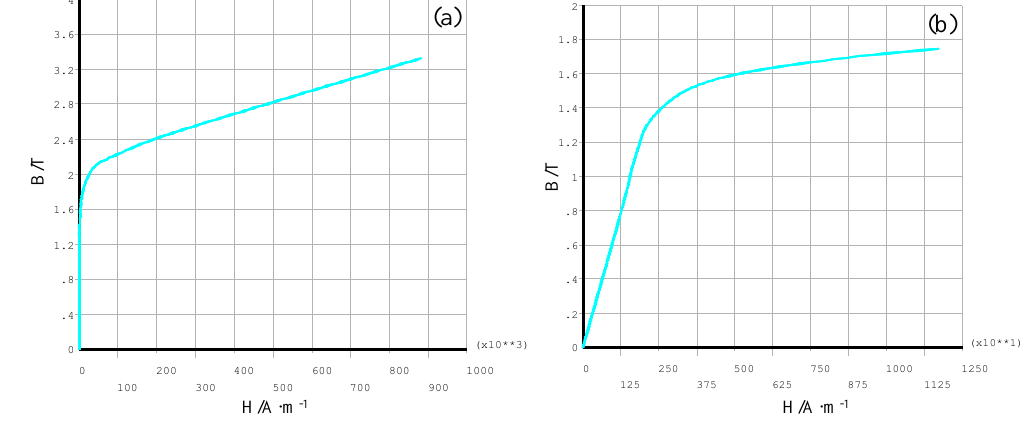
Figure 3. The B-H curves for the yoke iron ( a ) and the steel wire ( b ).